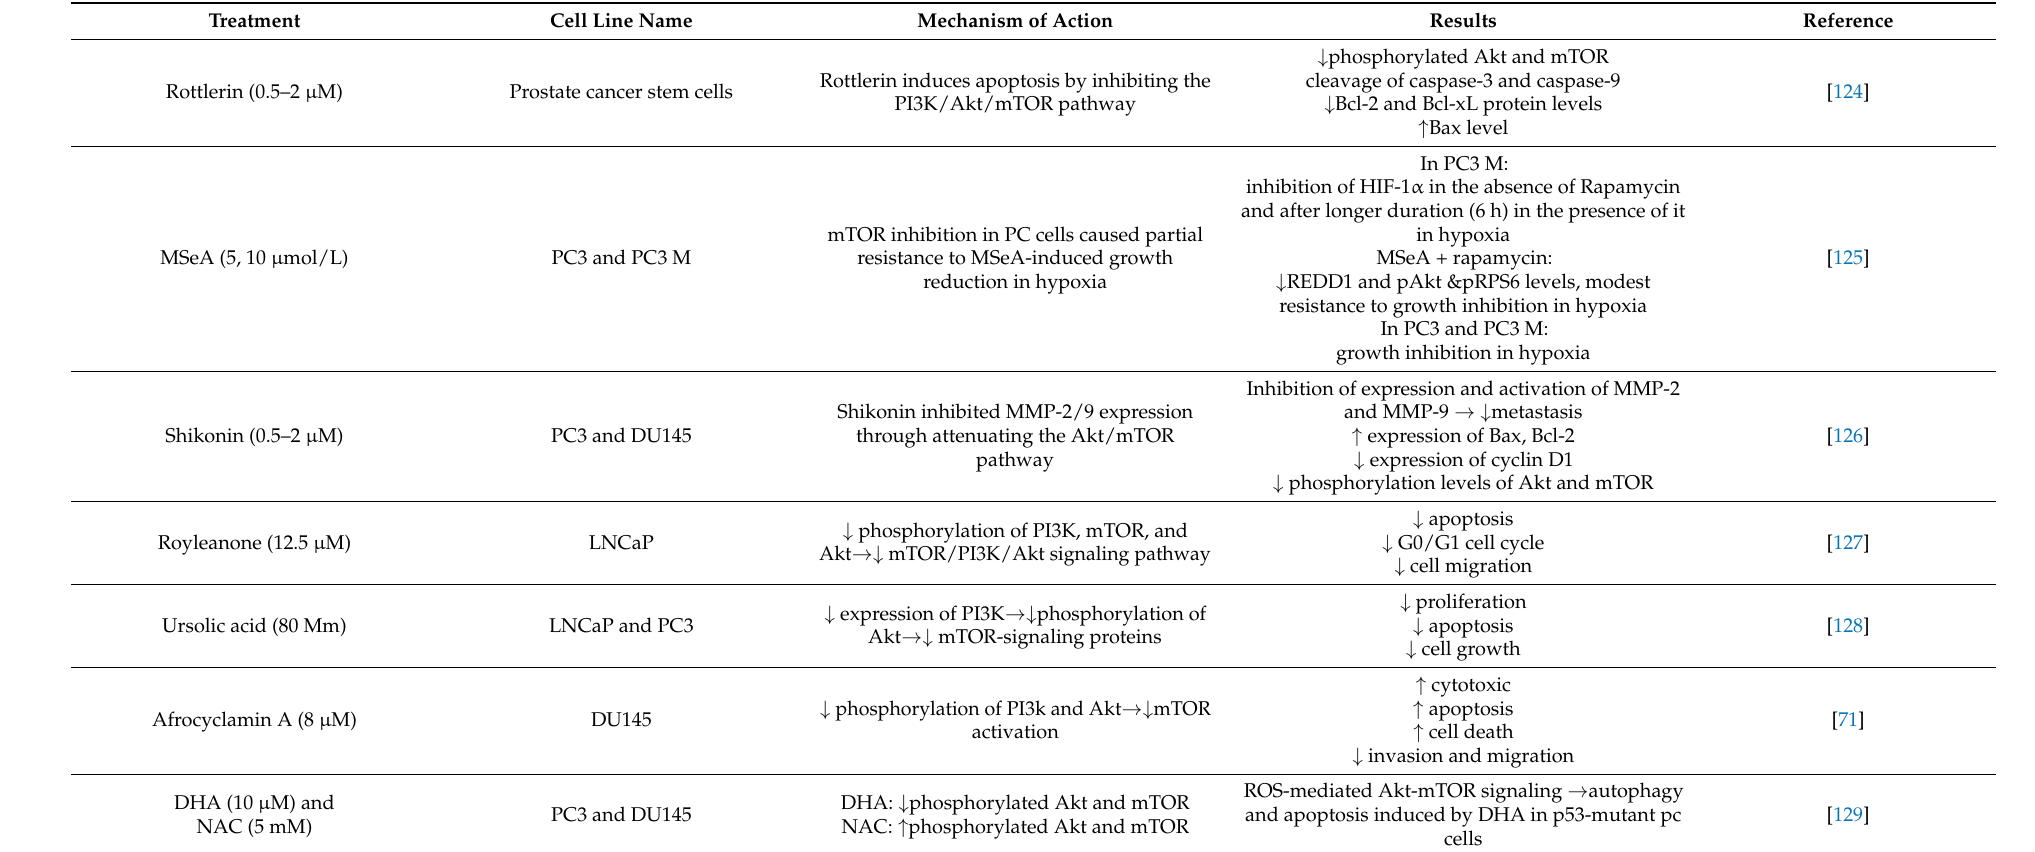
Table 4. In vitro studies on natural PI3K/Akt/mTOR inhibitors in